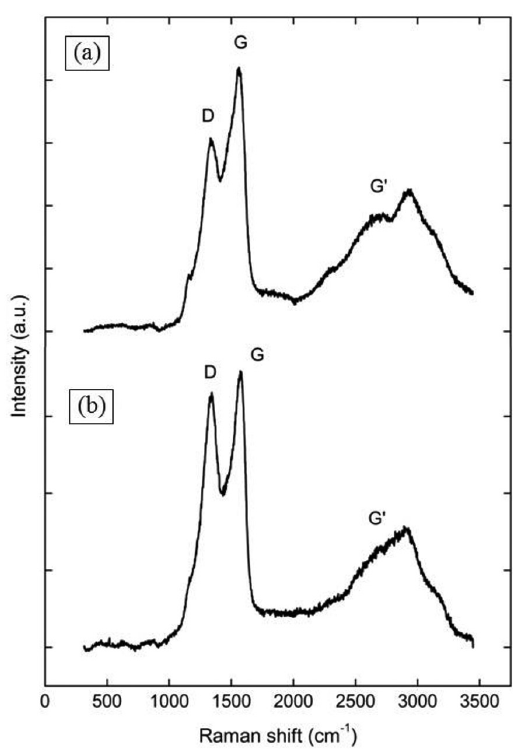
Figure 4. Raman spectra of BDUND grown on PS for (a) 3h and (b) 4h.